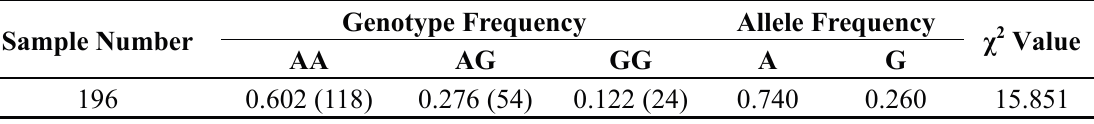
Table 2. Genetic variation analysis of the TAP1 gene exon 3 G729A mutation in Sutai pigs.